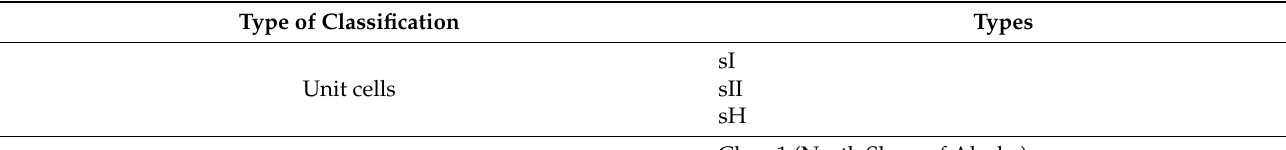
Table 1. Classification of gas hydrates.